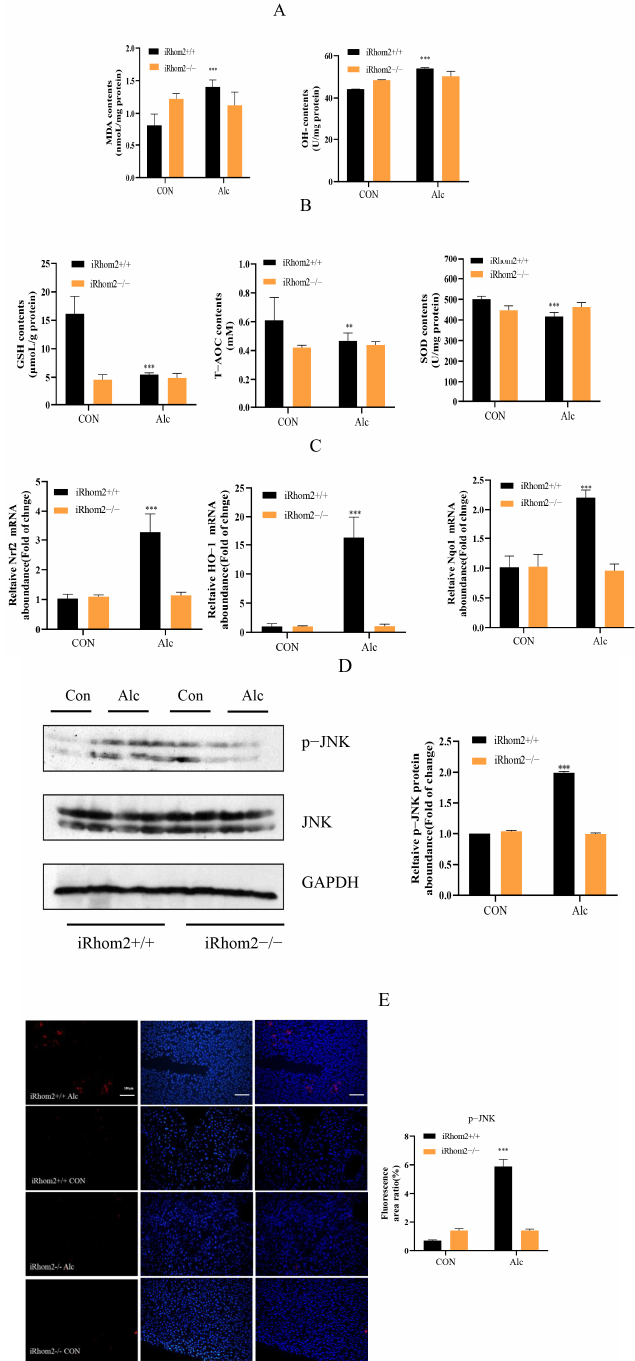
Figure 6. The iRhom2 knockout can reduce oxidative stress and JNK activation in alcohol-induced liver fibrosis in mice; ( A ) liver-oxidative-stress-related indicators, including total MDA and OH-; and ( B ) antioxidant activities of SOD, GSH, and T-AOC; ( C ) HO-1, Nrf2, and Nqo1 in the liver detected with qPCR; ( D ) WB analysis of phosphorylated JNK; ( E ) IF analysis of phosphorylated JNK in liver tissue sections. The data are expressed as an average ± SD ( n = 6). ** p < 0.01, and *** p < 0.001 vs. the control group (iRhom2+/+ group).